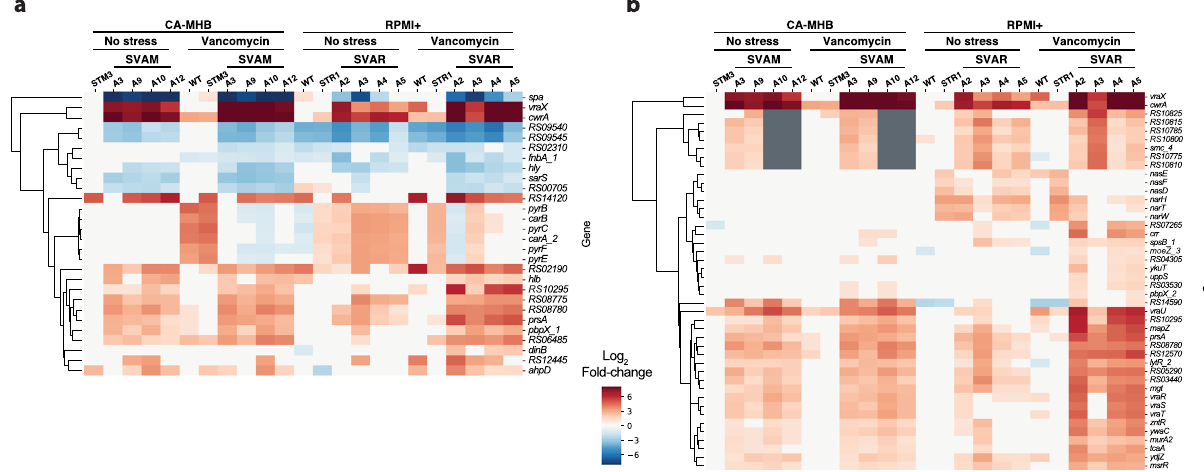
Fig. 5 Rearranged transcriptional landscapes of operons associated with vancomycin tolerance in TALE strains. a A heatmap of expression levels of the genes in the WalR regulon 57 displaying signi fi cant levels of differential expression, both up and down. b Expression of genes in the VraR cell wall stimulon 55 . STM: Staphylococcus aureus adapted to CA-MHB. STR: Staphylococcus aureus adapted to RPMI + . SVAM: Staphylococcus aureus tolerized to vancomycin in CA-MHB. SVAR: Staphylococcus aureus tolerized to vancomycin in RPMI +